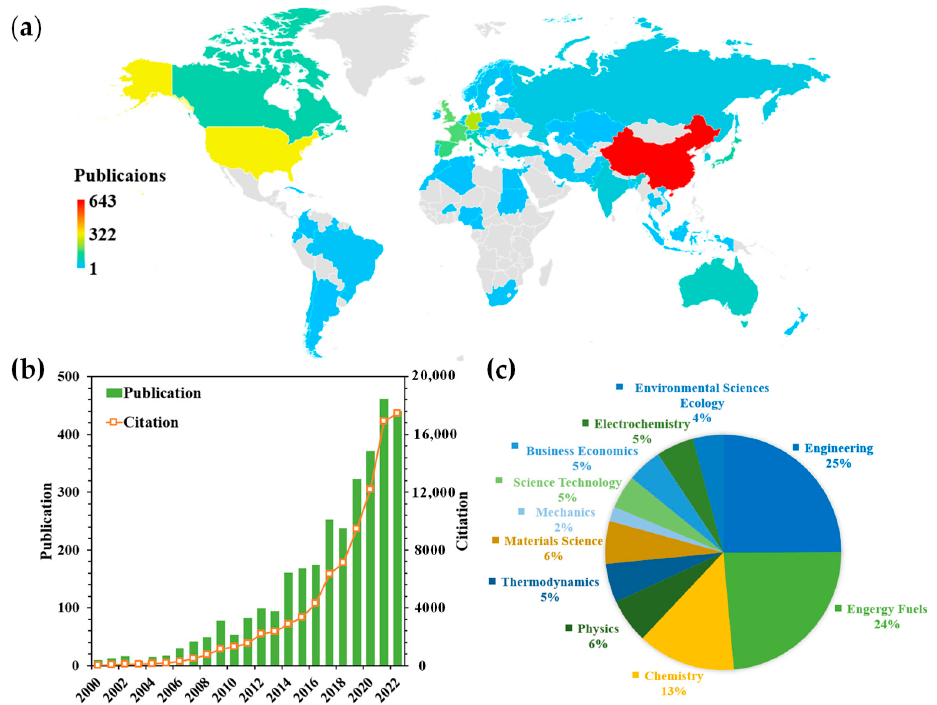
Figure 4. Global publications on the TCES technology (2000–2022): ( a ) geographical distribution; ( b ) publications and citations; ( c ) research area.